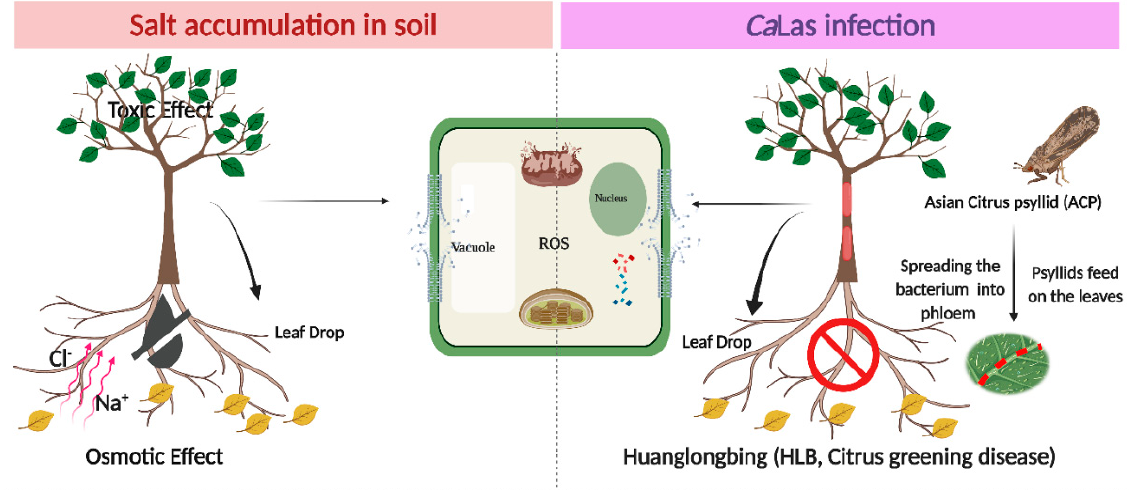
Figure 1. Schematic diagram of the interactive effect of abiotic stress (salt stress) and biotic stress (HLB) in the plant cell. The left photo shows the effect of sodium and chloride accumulation in soil, and the negative effects of NaCl stress resulting from three main factors: (1) The osmotic effect of increasing salt ions in the soil or apoplast, which decreases the availability of external water and creates a more negative internal tissue water potential as salt is taken up, (2) the toxicity of specific ions, and (3) the nutritional imbalance. On the right, HLB disease occurs following the movement of Ca Las through the phloem tissues. This results in blockage in the phloem tissues and impaired nutrient transport. Subsequently, the plant cells produce toxic reactive oxygen species (ROS) in the two molecular forms (free radicals and non-radical). ROS overproduction results in DNA and protein damage, lipid peroxidation, impairment of cell metabolism, interruption of cellular homeostasis, and consequently, cell death. The symptoms appear as leaf necrosis, growth suppression, leaf abscission, a decline in fruit production, and finally, plant death. The figure was created in BioRender.com.